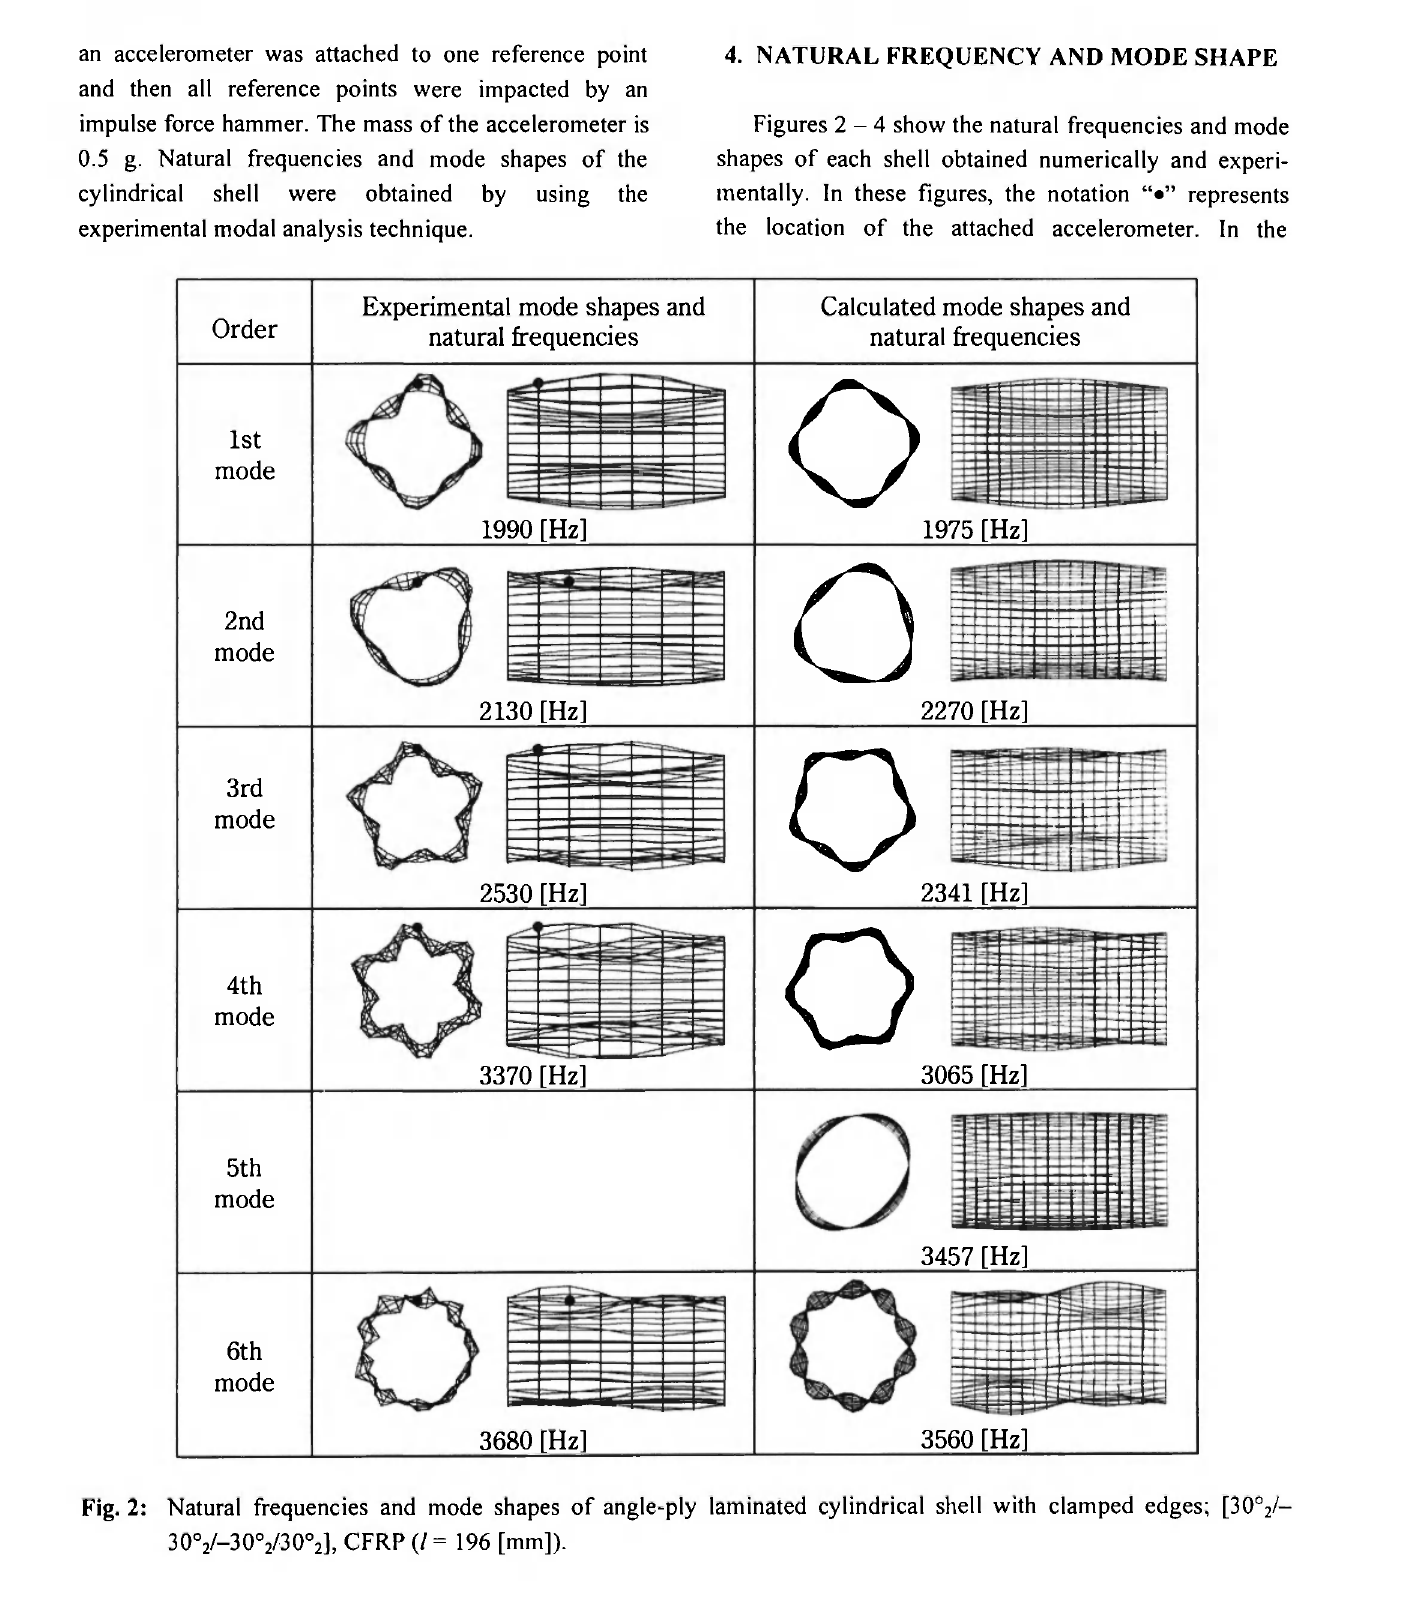
Fig. 2: Natural frequencies and mode shapes of angle-ply laminated cylindrical shell with clamped edges; [30° 2 /- 30° 2 /-30 ο 2 /30 ο 2], CFRP (/ = 196